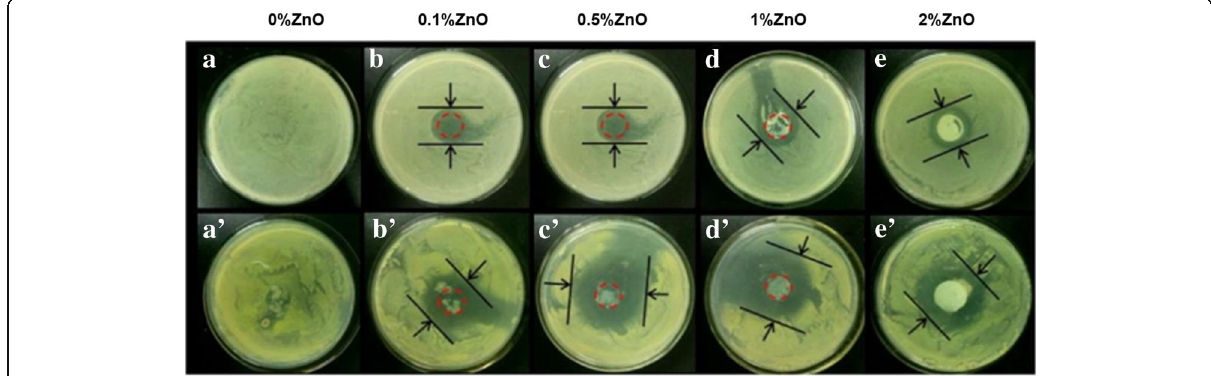
Fig. 3 Antibacterial property of caprolactam-casein (a, a ’ ) and caprolactam-casein/ZnO (b-e, b ’ -e ’ ) nanocomposites against (a-e) E.coli and (a ′– e ′ ) S.